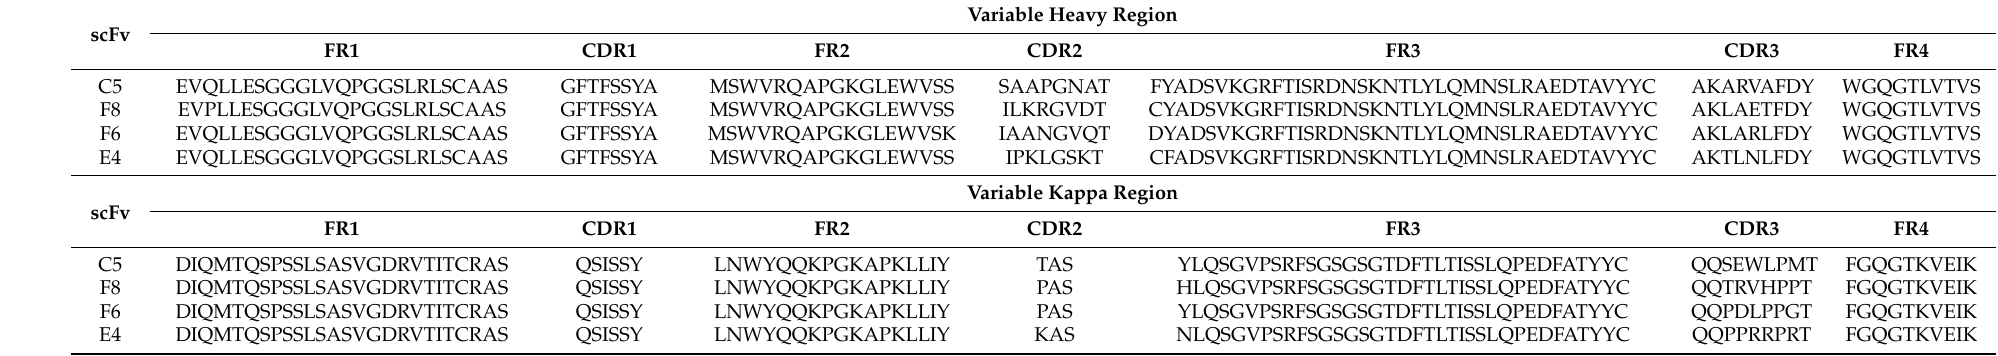
Table 4. CDR determination from four scFv amino acid sequences of the variable heavy (VH) region and variable kappa (V κ ) region using